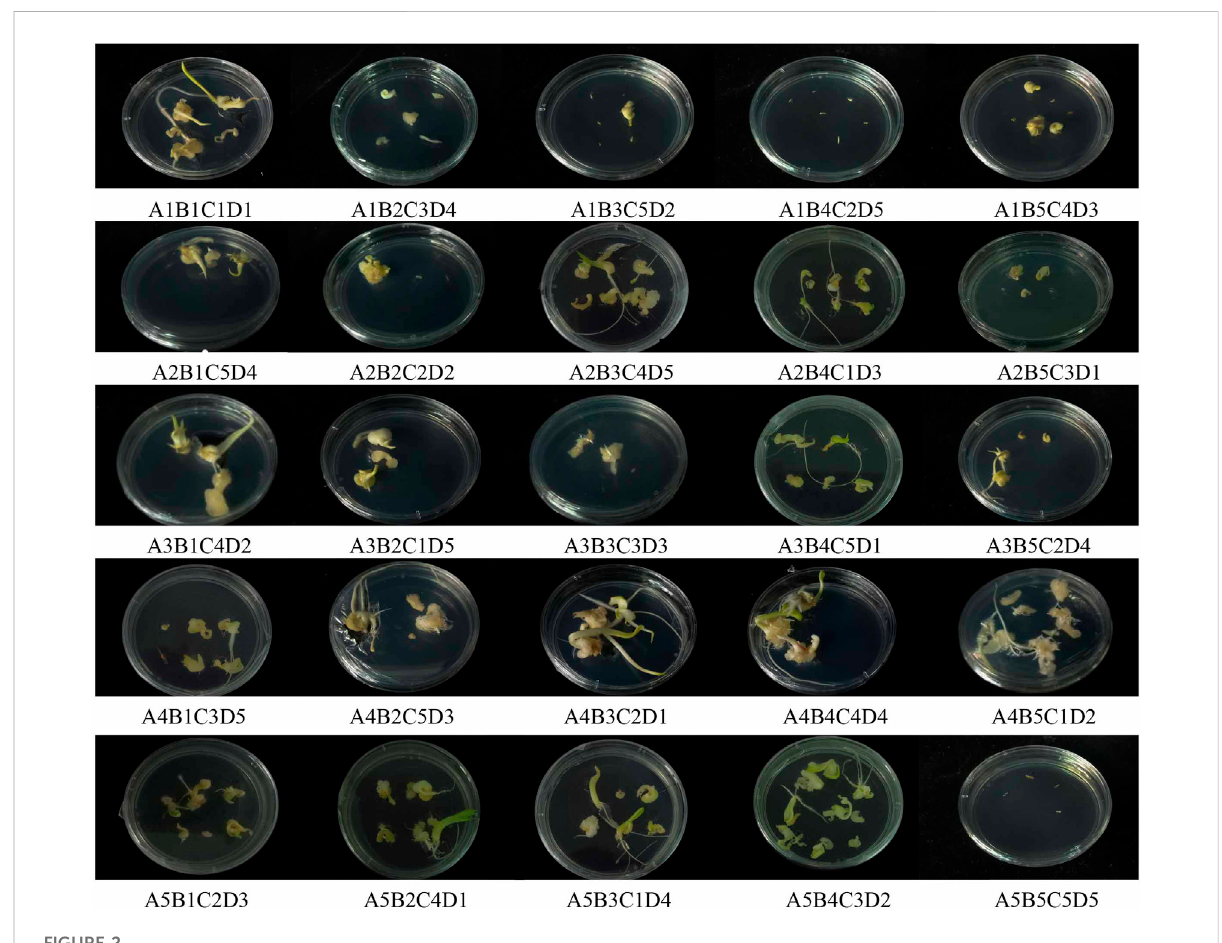
FIGURE 2 Callus induction in hybrid seeds embryo of calla lily by different orthogonal